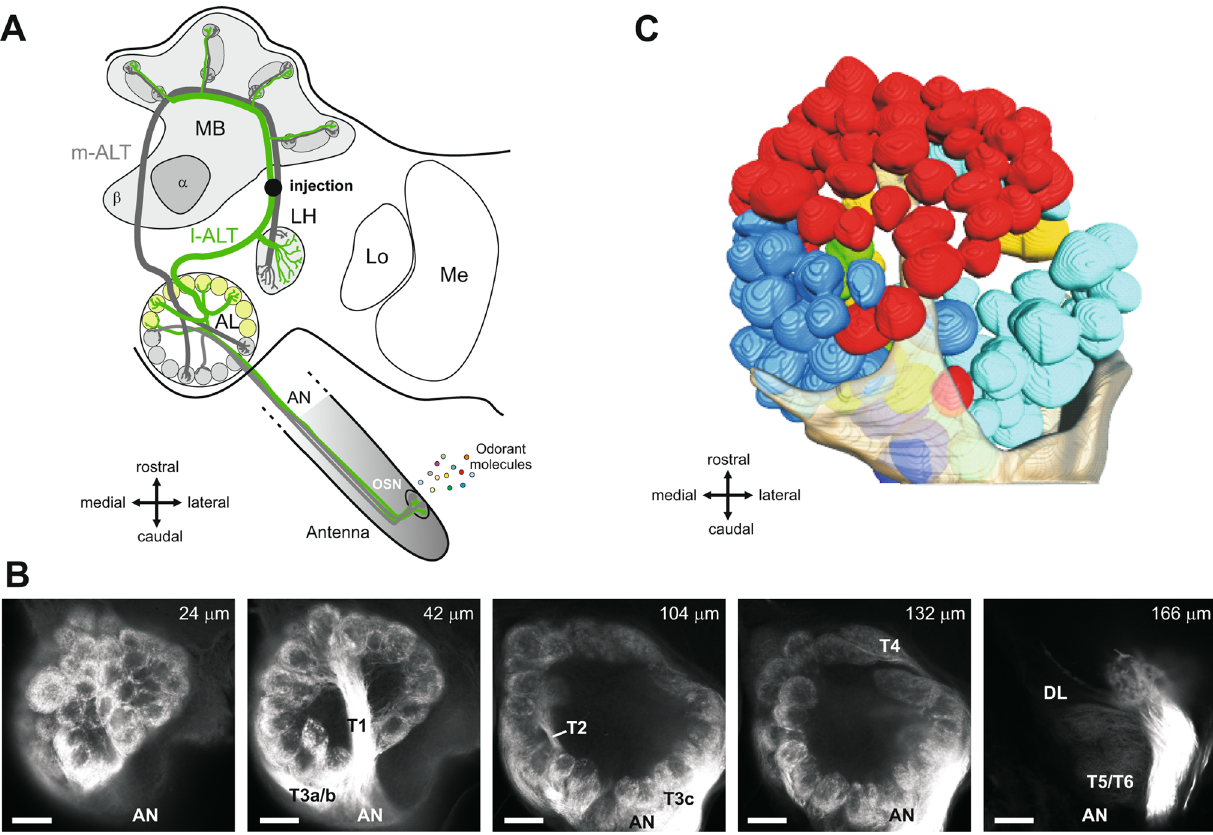
Figure 1. Anatomy of the bumble bee antennal lobe (AL). ( A ) Hymenopteran dual olfactory pathway (adapted from Carcaud et al. 2012). Odorant molecules are detected by olfactory sensory neurons (OSNs) on the antenna, which form the antennal nerve (AN) and send olfactory information to the primary olfactory center, the antennal lobe (AL). Then, projection neurons (PNs) convey information to higher-order centers, the mushroom bodies (MB) and the lateral horn (LH), using two main tracts, the l-ALT (lateral antennal-lobe tract, in green) and the m-ALT (medial antennal-lobe tract, in grey). PNs of the m-ALT and l-ALT project to distinct areas in the MB and in the LH. The black dot indicates the site of injection for calcium imaging. Lo: lobula, Me: medulla, α: α-lobe, β: β-lobe. ( B ) Confocal image sequence through a bumble bee antennal lobe (left lobe) obtained by anterograde antennal staining (using tetramethylrhodamine dextran). The scale bars indicate a length of 50 µm. The depth along the z-axis of the confocal images are indicated on the top right of each image. AN: antennal nerve. T1-T4: subdivisions of the antennal nerve in the AL. ( C ) Three-dimensional reconstruction of the 158 glomeruli in the antennal lobe presented in B. The glomeruli are colored depending on their input tracts. The numbers of glomeruli per input tracts are: T1 = 60 (red), T2 = 7 (green), T3a = 27 (medium blue), T3b = 16 (dark blue), T3c = 42 (turquoise), and T4 = 7 (yellow) glomeruli. The antennal nerve is shown in semi-transparent